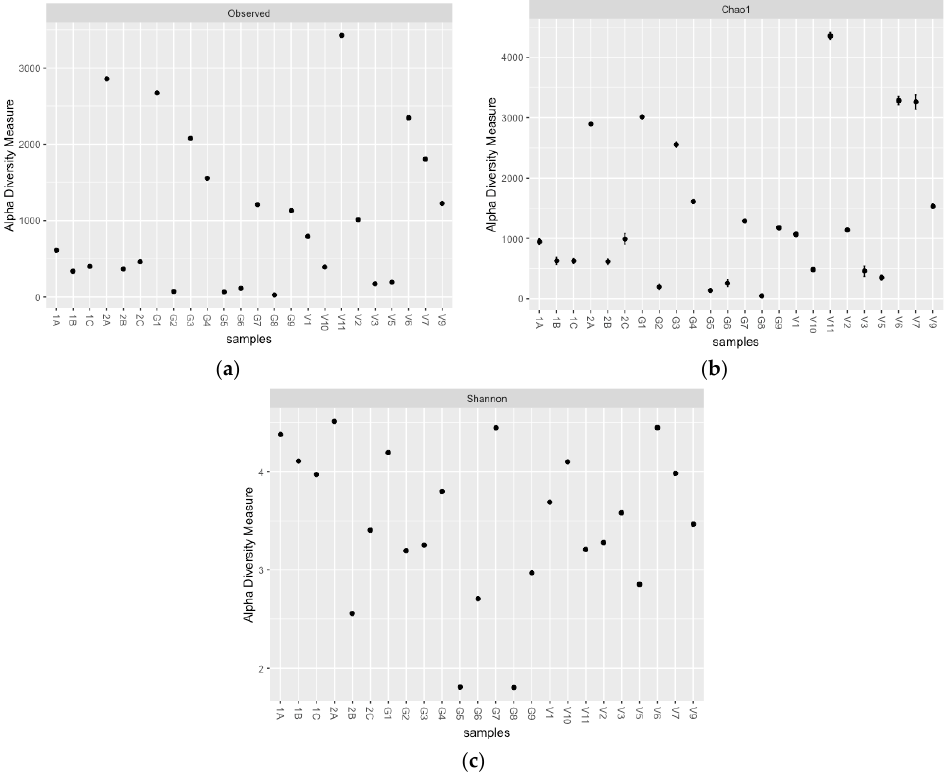
Figure 4. Fungal species richness observed ( a ) and predicted ( b ) for the NR, GK, and VV samples, as well as the fungal diversity (Shannon index; ( c ). NR = Nuwejaars River system (1A-2C; developing peatland); GK = Goukou River system (G1–G9; impacted peatland); VV = Vankervelsvlei (V1–V12; undisturbed